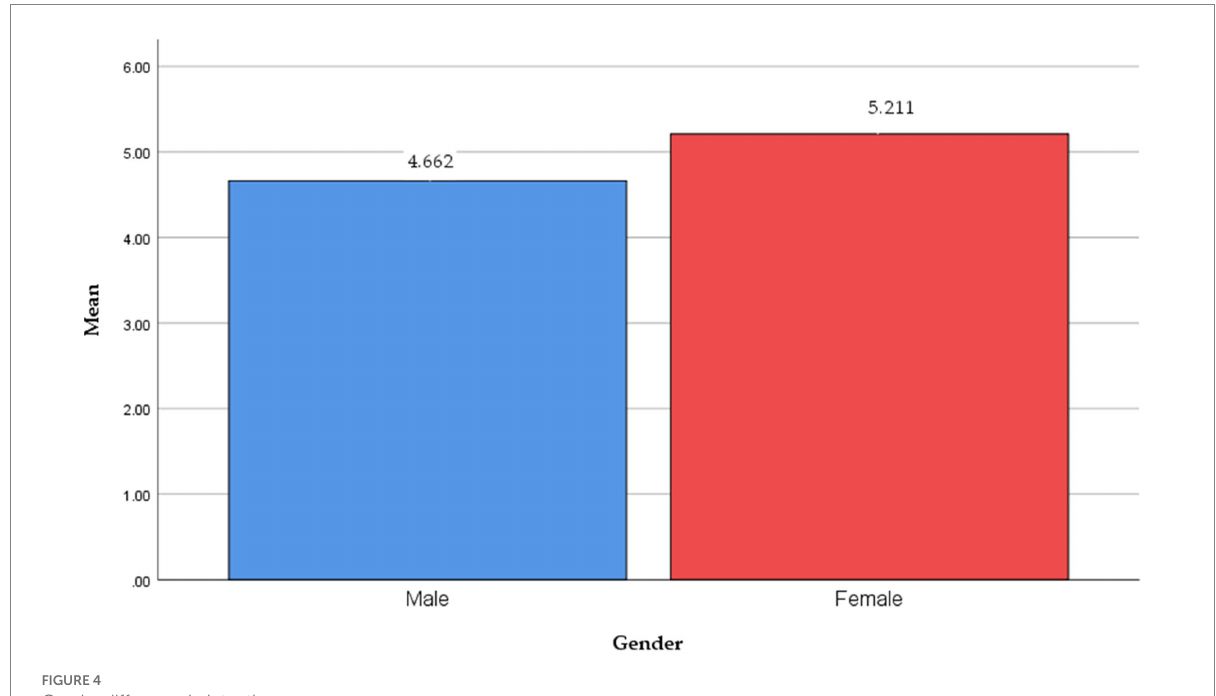
FIGURE 4 Gender difference in